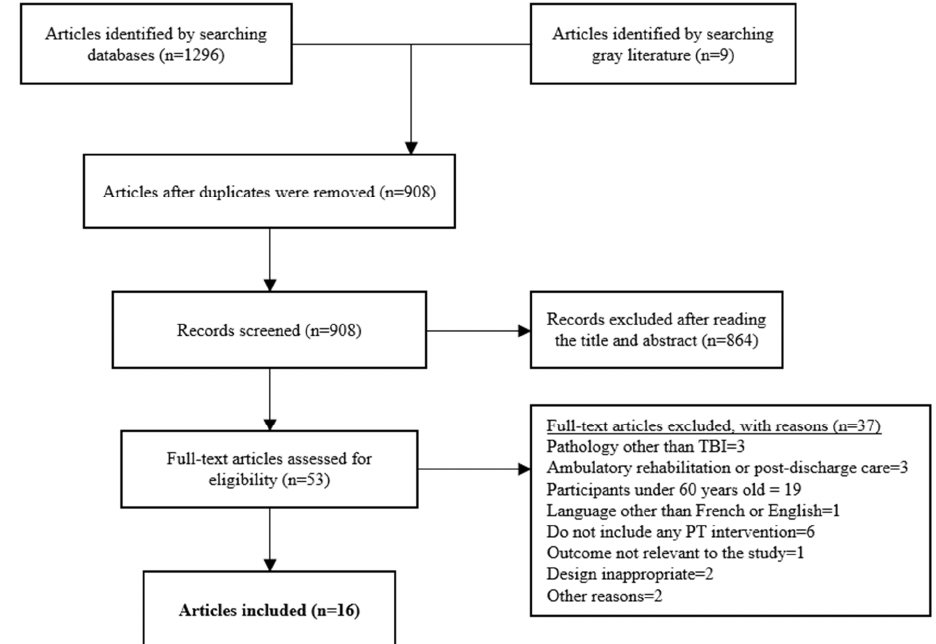
Figure 1. Flowchart according to PRISMA for Scoping Reviews. Table 1. Summary of the sources and characteristics of the articles included in this scoping review.